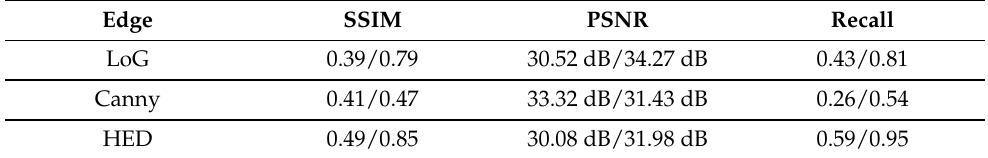
Table 1. Average SSIM, PSNR and Recall between edges or IR images and visual images before/ after